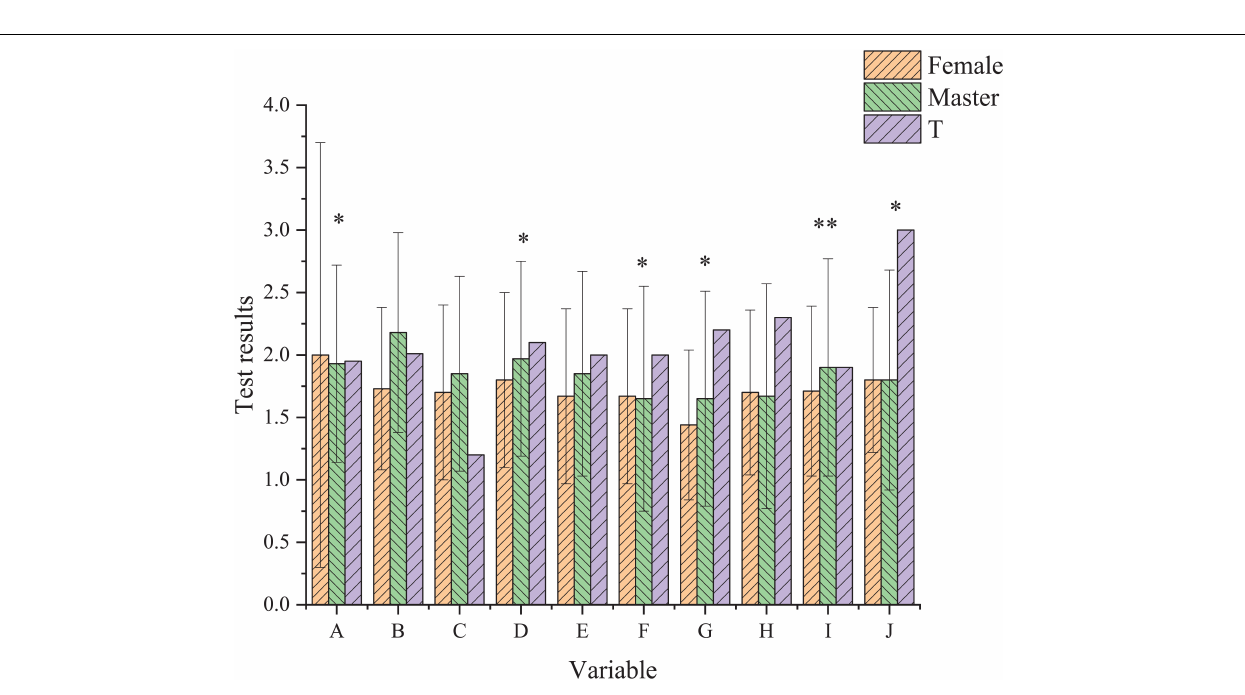
Frontiers in Psychology |